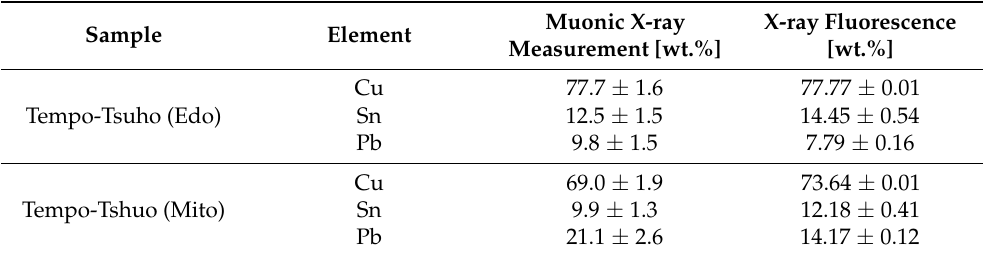
Table 1. Elemental composition of the two coins in wt.%. The real coin is the Tempo-Tsuho (Edo), while the counterfeit is the Tempo-Tsuho (Mito). Results are compared with XRF. Data was taken and adapted from